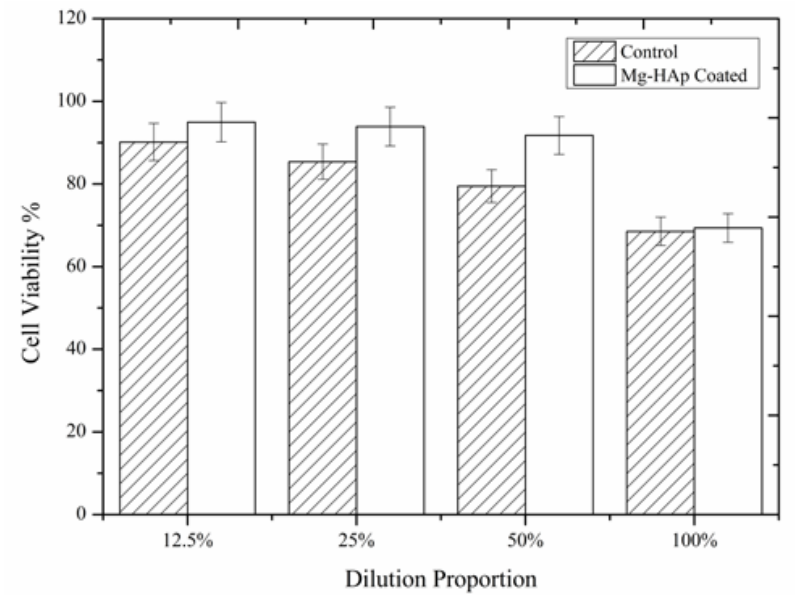
Figure 9. Cell viability at different dilution ratios.